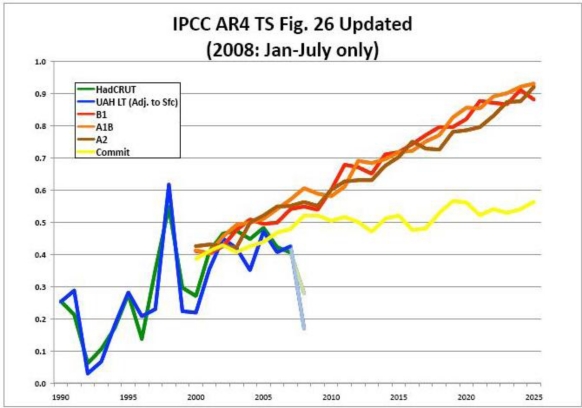
HadCRUT3 and UAH versus IPCC model global surface warming. Source: [80], based on a graph prepared by Dr. John Christy.